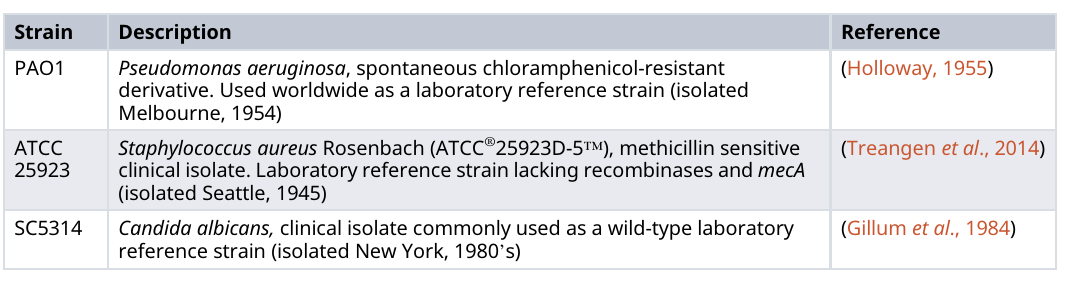
Table 1. Microbial strains used in this